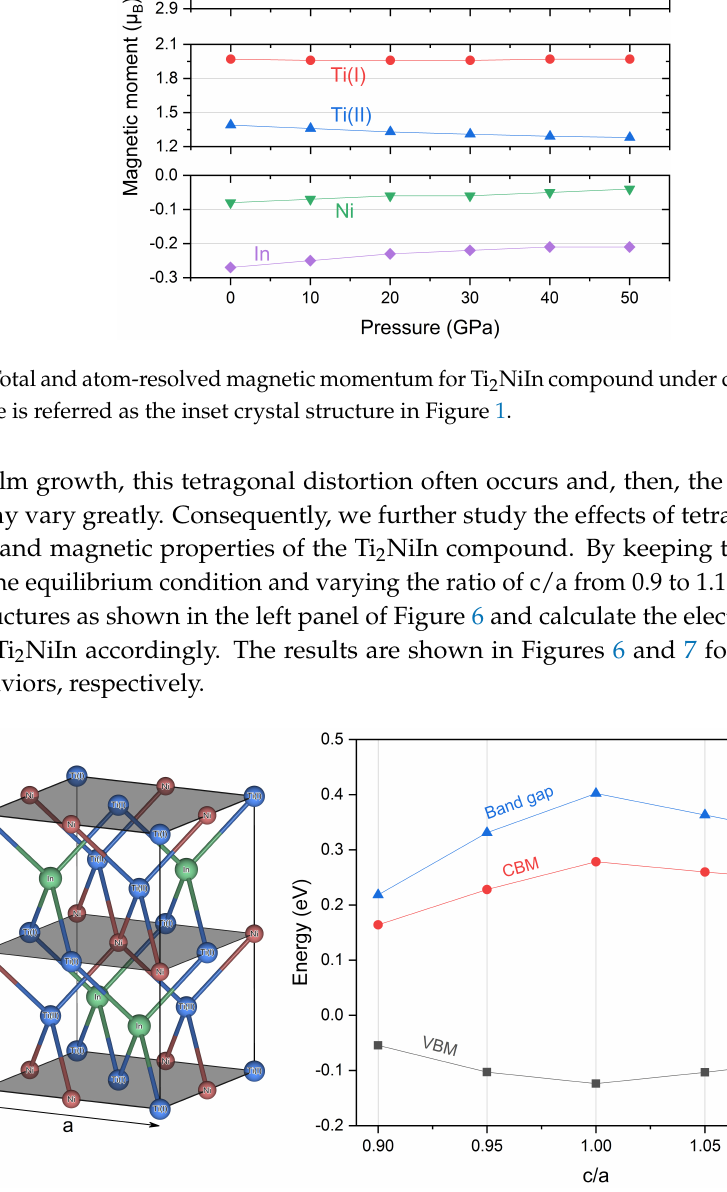
Figure 6. The tetragonal structure and the conduction band minimum (CBM), valence band maximum (VBM) and band gap in the minority spin channel of Ti 2 NiIn compound under tetragonal deformation of different c/a